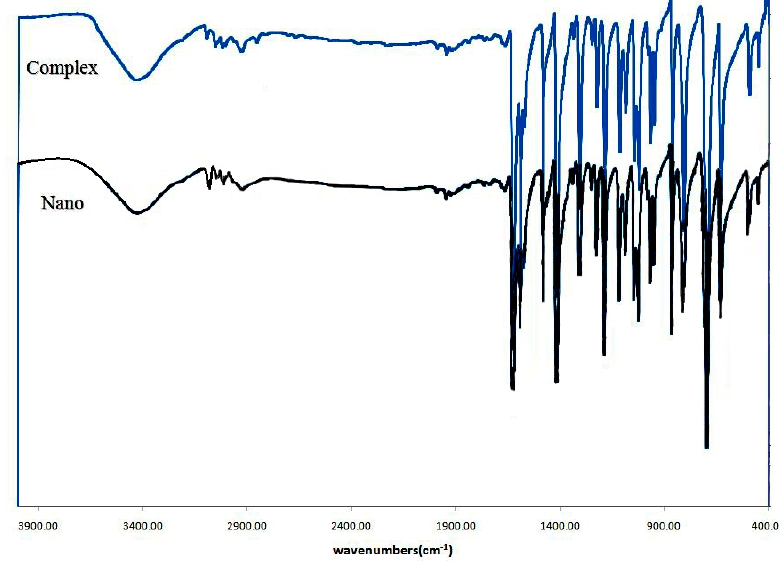
Figure 1. FT-IR spectrum of crystal and nano structure of 1 .